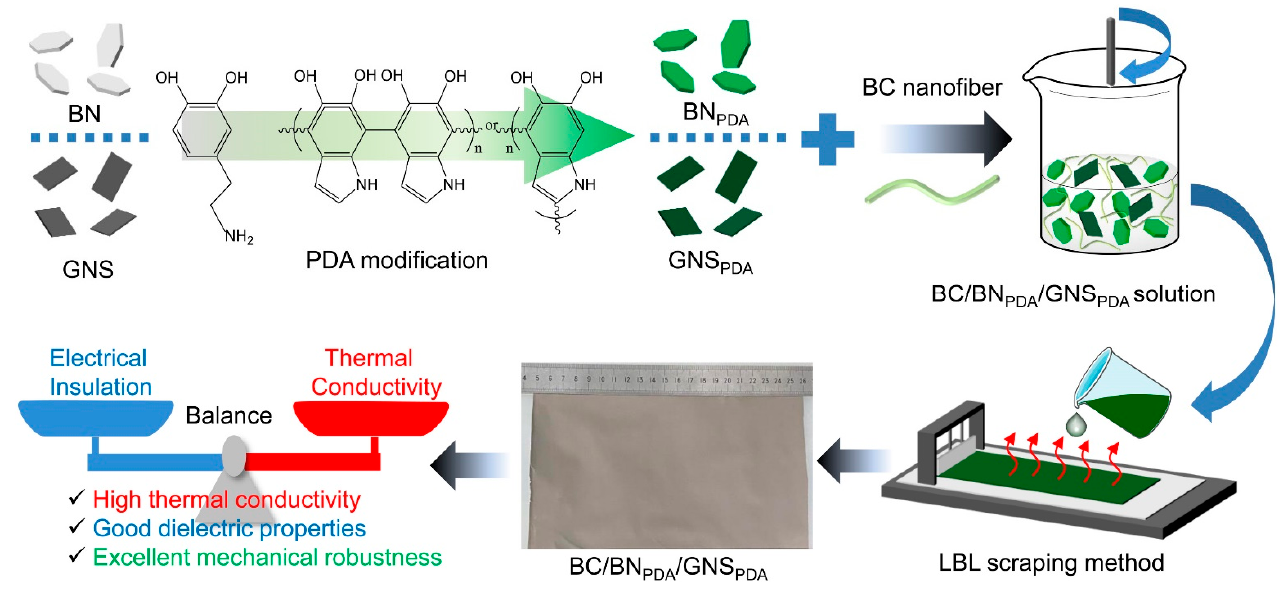
Scheme 1. Schematic illustration of design strategy. Construction of the